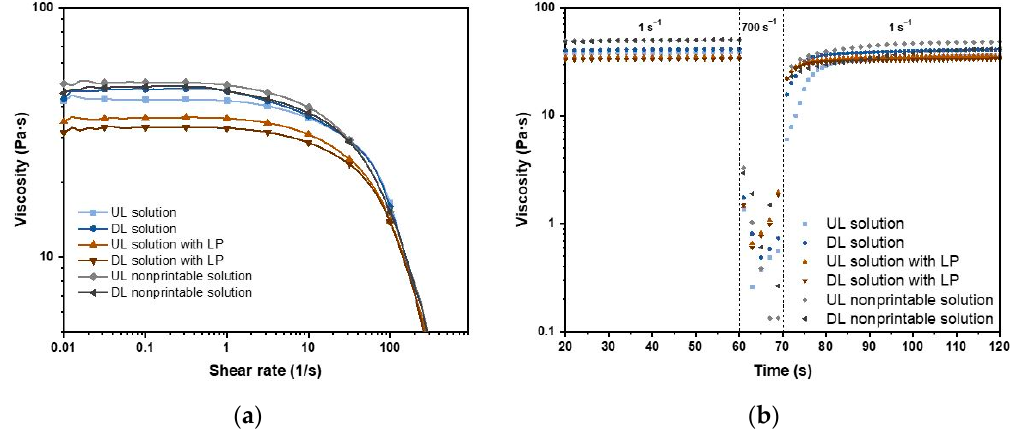
Figure 3. ( a ) Viscosity vs. shear rate curves of the formulations and ( b ) thixotropic behavior for the formulations sheared at 1 s − 1 for 60 s, 700 s − 1 for 10 s, and 1s − 1 for 120 s.